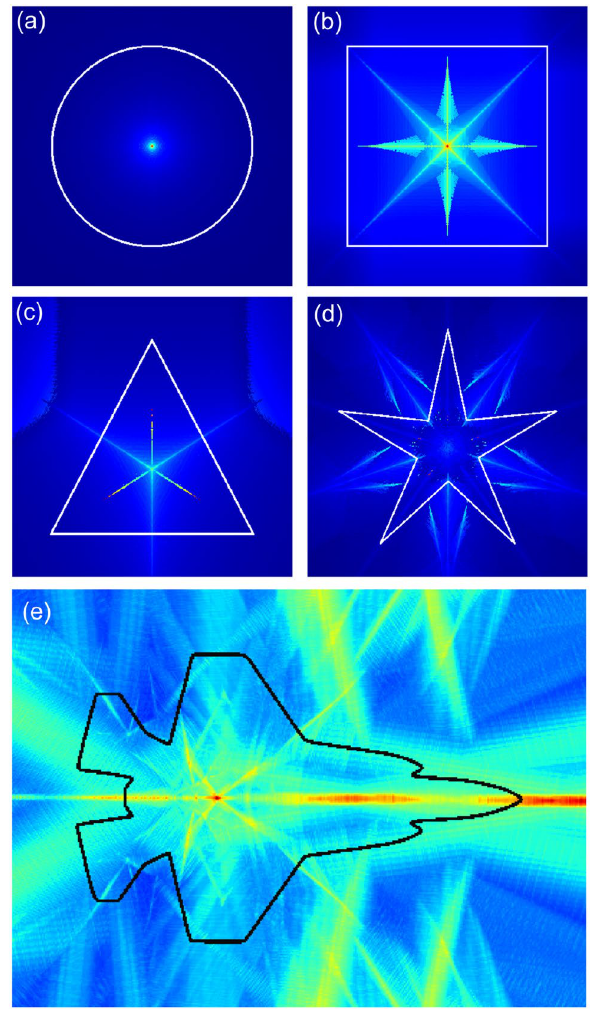
Figure 9. The result of an implementation of Algorithm 1 in Python for a circle ( a ), square ( b ), triangle ( c ), star ( d ), and an aircraft shows a point and fractal like mirroring of the mirror symmetry density